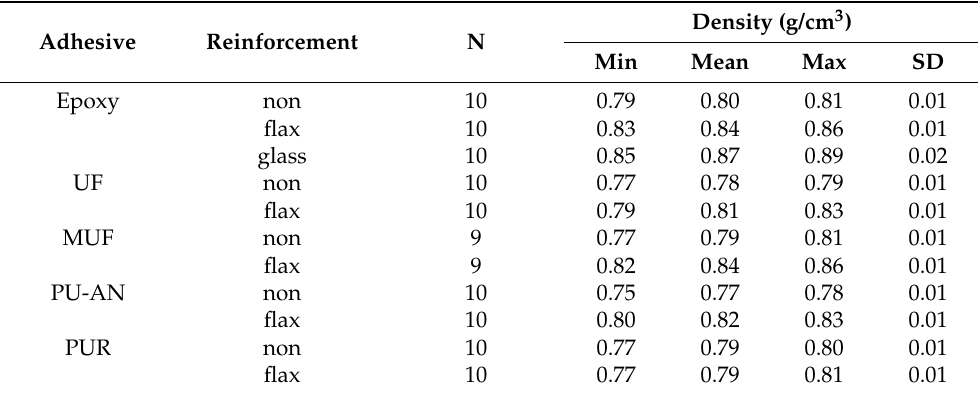
Table 2. Density of different